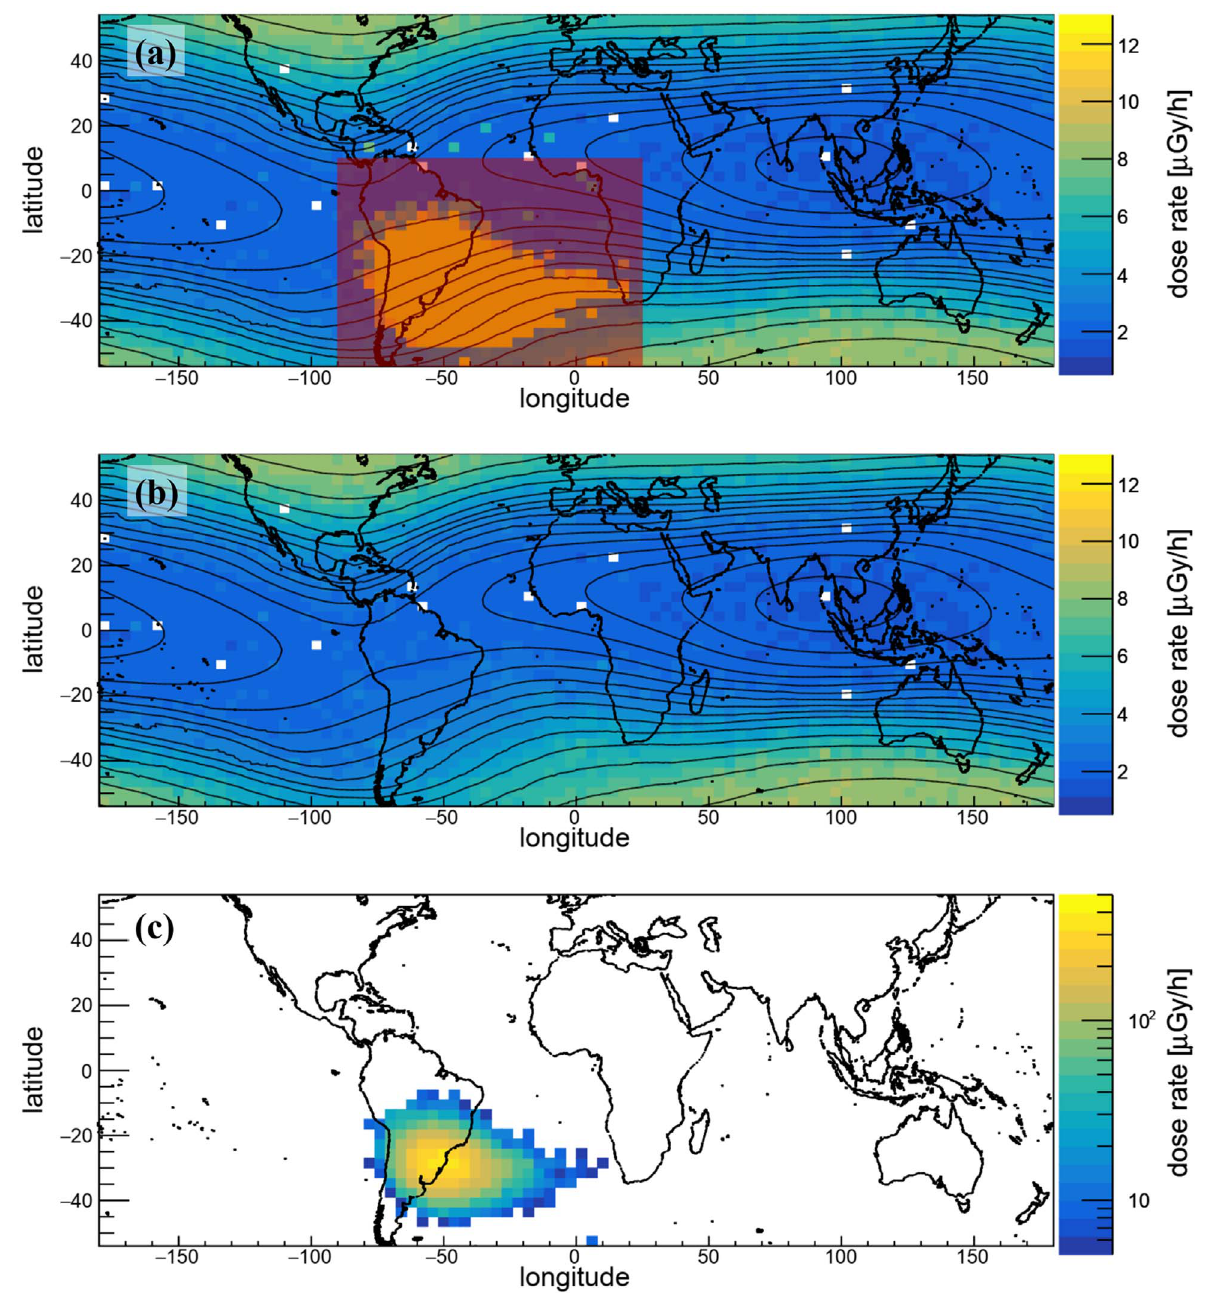
Fig. 4. D3D D-1 dose rate measurements and SAA separation, exemplarily for March 2015: (a) full data set, geographical cut illustrated by the red shaded box; contour lines show the cut-off rigidity in 1 GV steps; (b) Final GCR (see column GCR DLR in Table 2) based on the GCR contribution outside the SAA (GCR w/o – Table 2) plus the GCR contribution inside the SAA (GCR in SAA – Table 2); and (c) SAA (see column SAA DLR in Table 2) based on the SAA contribution with GCR (SAA w – Table 2) minus the GCR contribution inside the SAA (GCR in SAA